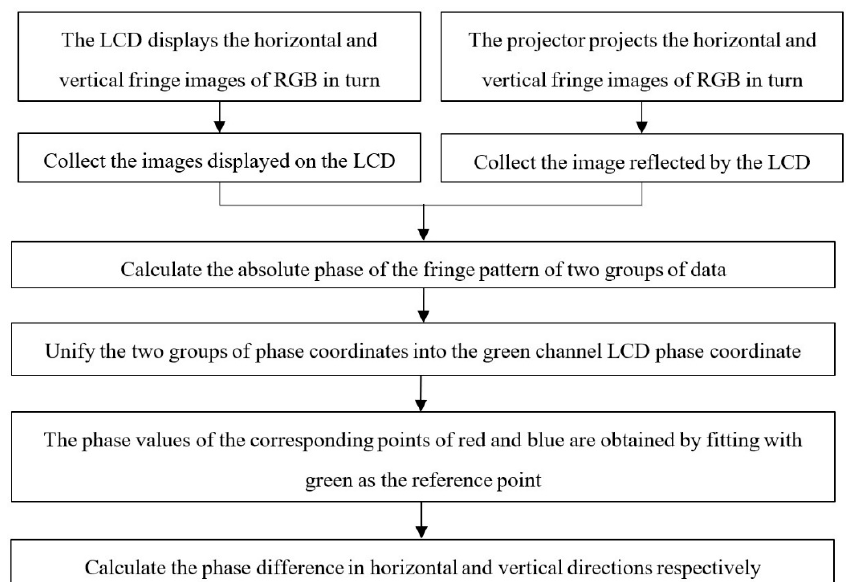
Figure 3. Flow chart of radial chromatic aberration calibration.